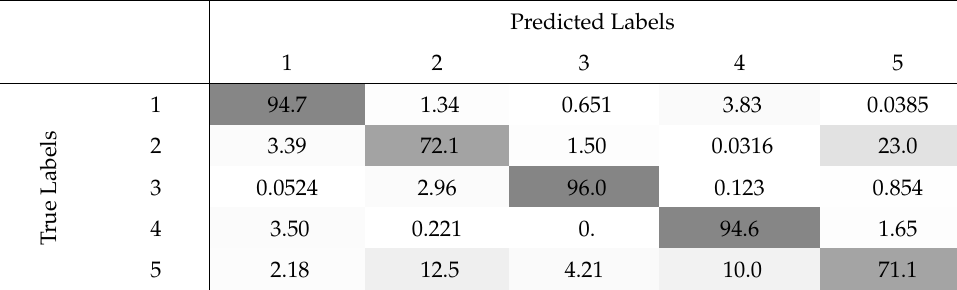
Table 5. Experiment II: Confusion matrix of our tree-based